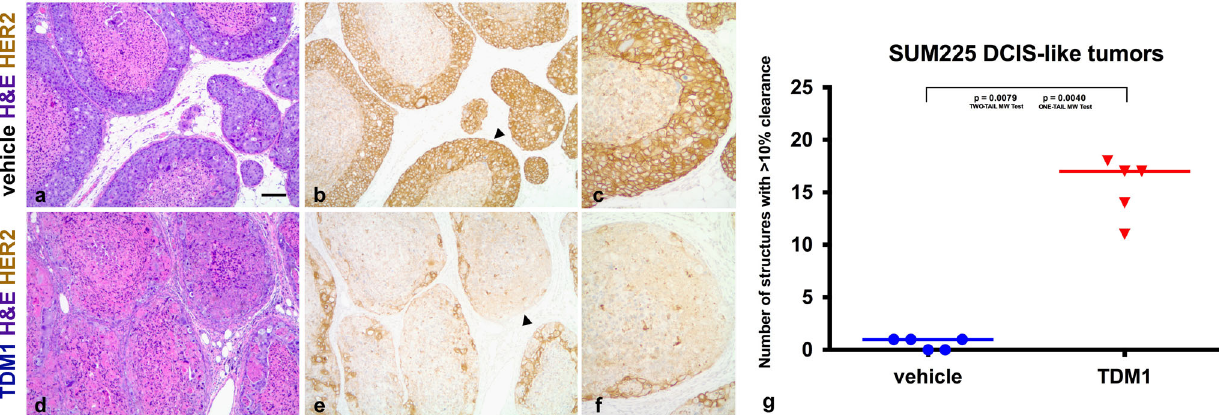
Fig. 4 T-DM1 treatment eliminates the outer and inner tumor cells. Representative H&E stained sections from vehicle-treated ( a ) and T-DM1- treated ( d ) SUM225 tumors are presented alongside serial section HER2 IHC ( b , c ) and ( e , f ). Arrowheads in b , e highlight the tumor nests that are presented in c , f . Note the signi fi cant elimination of HER2+ tumor cells post-T-DM1 treatment ( e , f ). Note niche-localized, and non- localized, cells are ultrasensitive to T-DM1 treatment. Pathological assessment of clearance was performed as described in the methods ( g ). Data was summarized across fi ve vehicle-treated and fi ve T-DM1-treated SUM225 tumors (Mann – Whitney test vehicle vs. T-DM1; p value = 0.0040 one-tail and p value = 0.0079 two-tail). Each line represents the median. Scale bar, ~100 μ